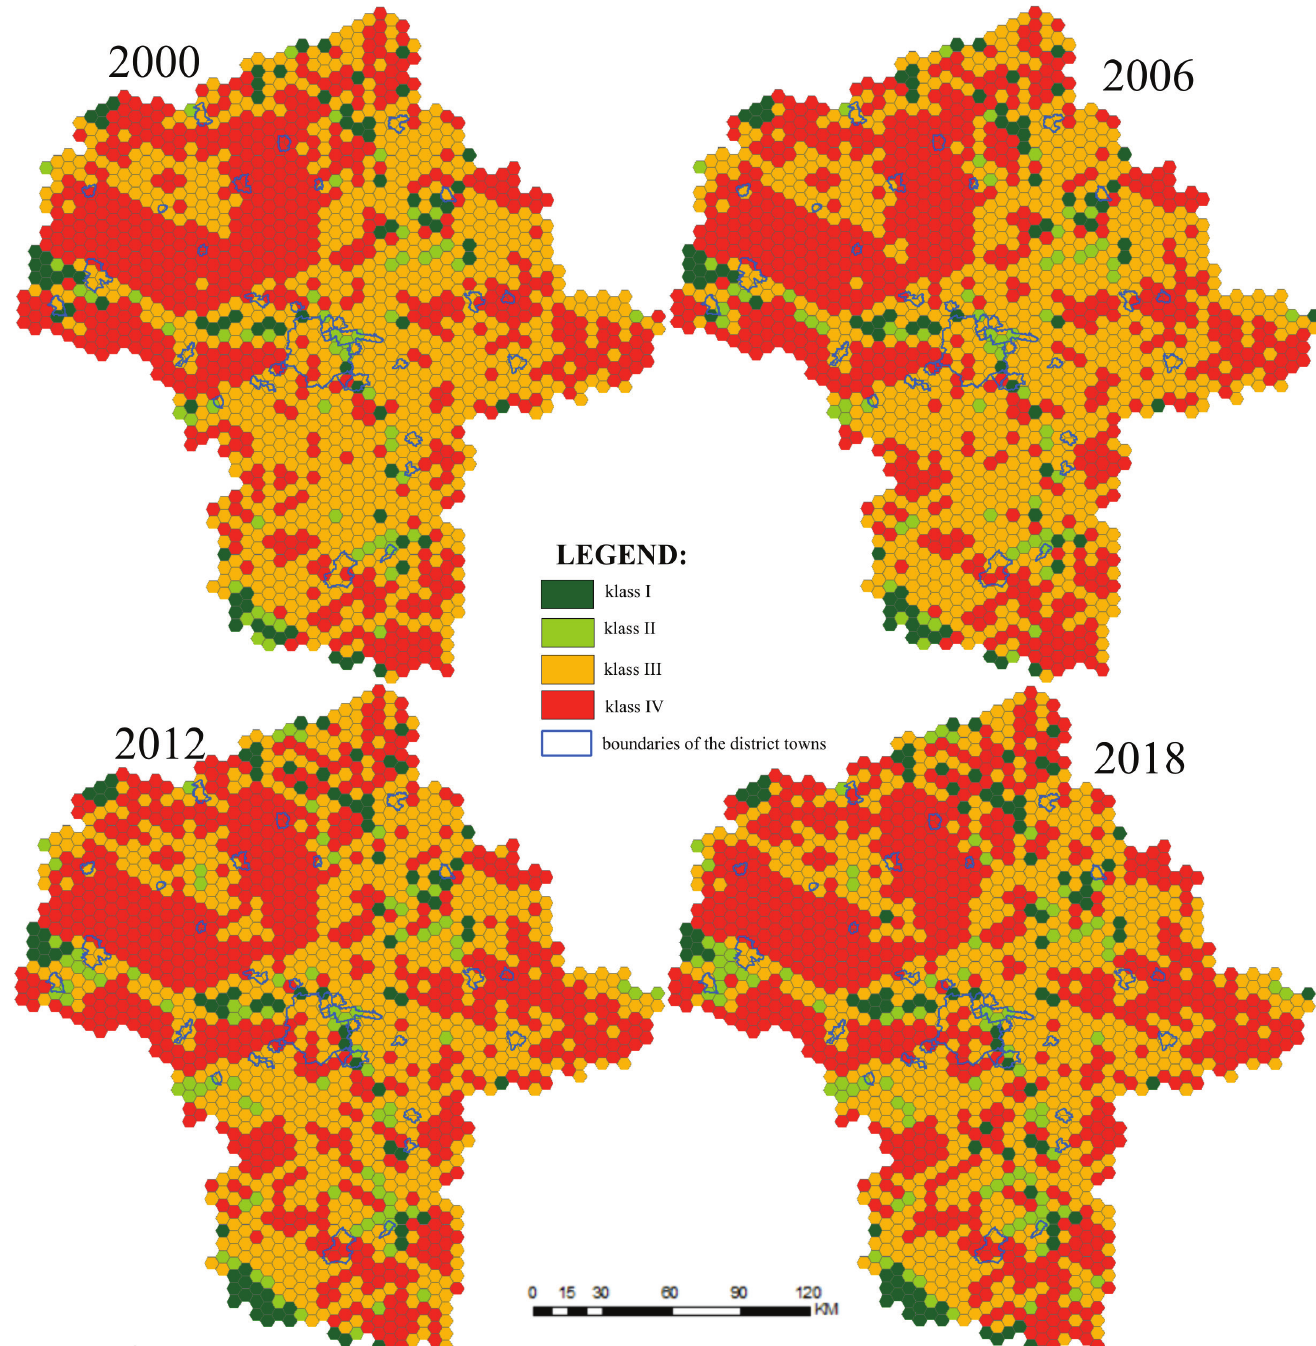
Figure 5. Spatial distribution of land transformation classes in 2000, 2006, 2016 and